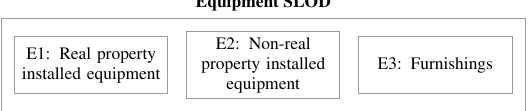
Figure 10. Levels of equipment and furnishings SLOD